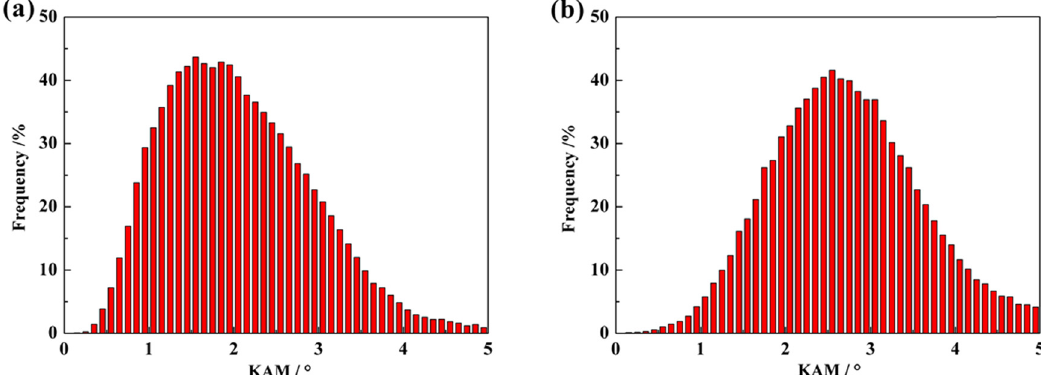
Figure 17: KAM statistical chart of cold - rolled plate ( a ) Y - free and ( b ) Y -